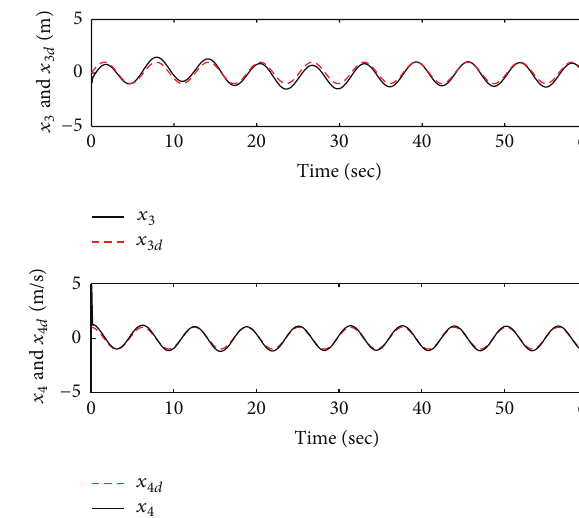
Figure 16: The sliding surfaces 𝑠 1 and 𝑠 2 .